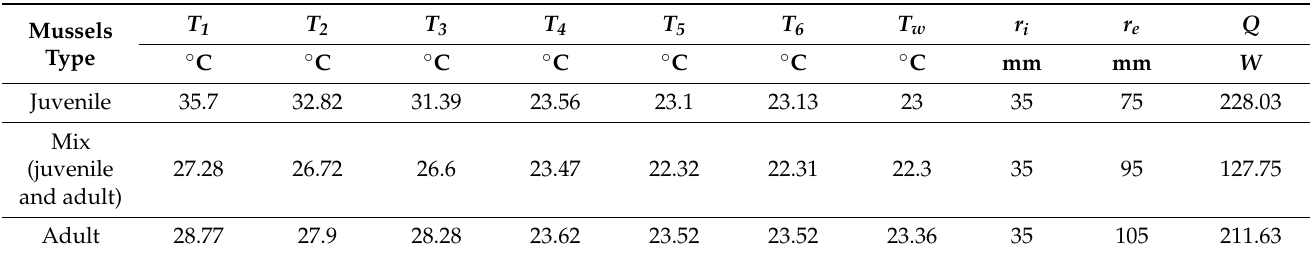
Table 1. Distribution of measured temperature around the aluminum tube for different ages of mussels uniformly distributed.